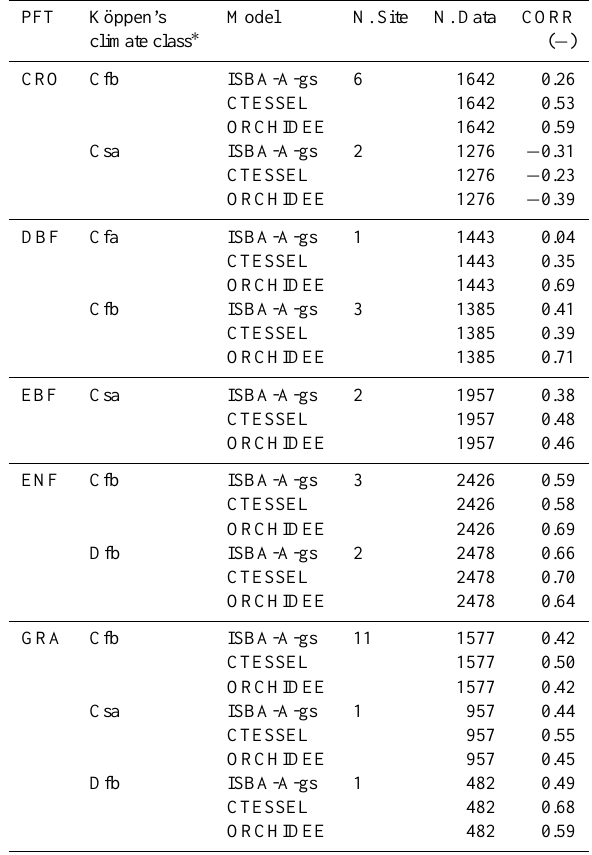
Table 4. Performance of the simulations (ISBA-A-gs, ORCHIDEE, CTESSEL) of daily NEE for all PFTs and Köppen’s climate classes on site × year basis: ENF – evergreen needleleaf forest; EBF – ev- ergreen broadleaf forest; DBF – deciduous broadleaf forest; GRA – grassland; and CRO – cropland; N.Site – number of available sites for each PFT; N.Data – number of available days; CORR – correla- tion